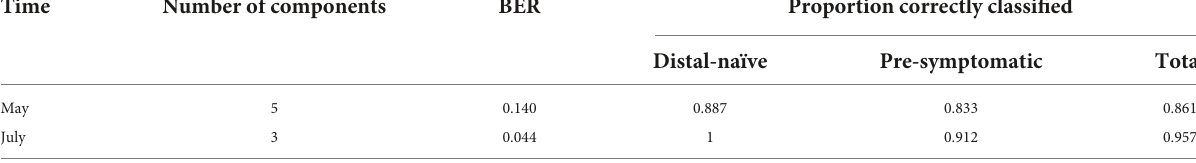
CV,crossvalidation. TABLE 3 Accuracies of the sparse partial least squares discriminant analysis (sPLS-DA) used to classify leaf near-infrared (NIR) spectra based on tree symptom type for the May and July datasets. Time Number of components BER